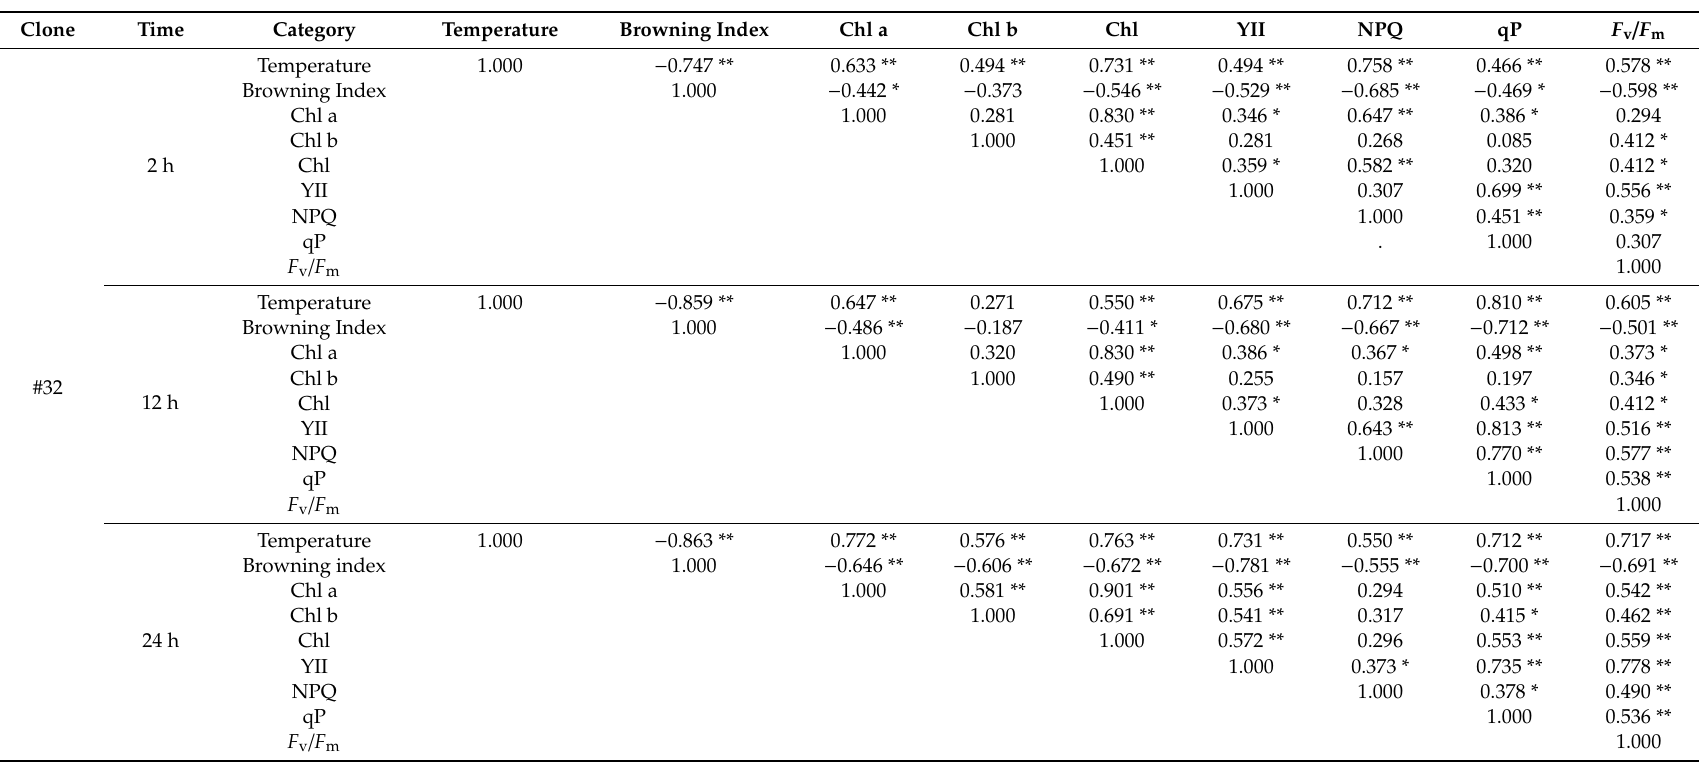
Table A2. Correlation analysis of physiological indexes of C. fortunei under LT (from 25 to − 12 ◦